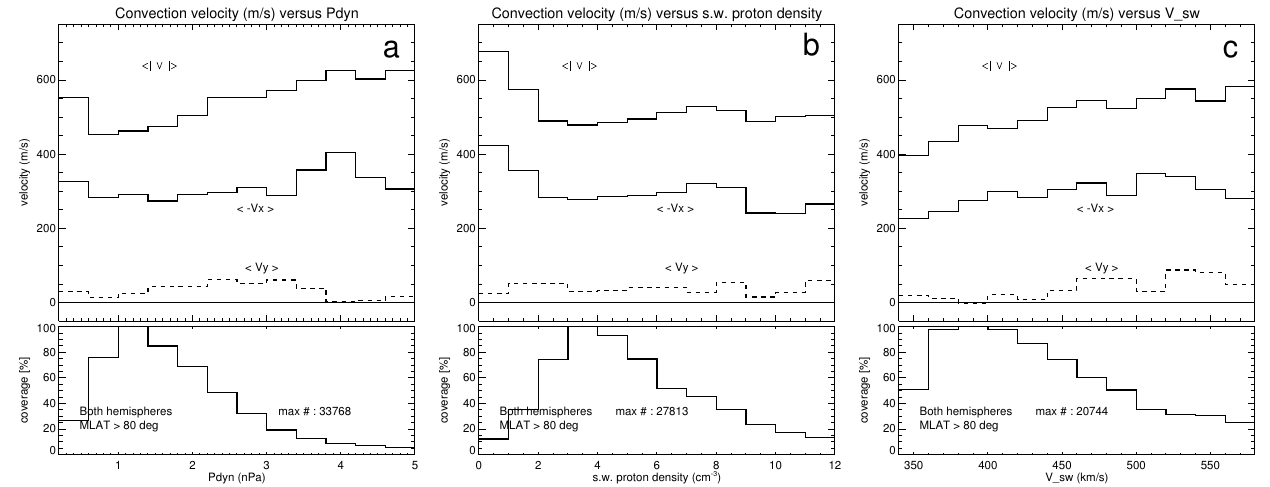
Fig. 10. (a) :The polar cap convection velocity shown as function of the solar wind dynamic pressure P dyn ; (b, c) : the corresponding dependencies of the solar wind proton density n p and velocity | V s.w. | . Data points from both hemispheres have been combined for the analysis. The bottom panels indicate the spatial coverage characteristics for each bin within the high-latitude area ( | φ m | > 80 ◦ ). the dayside reconnection X-line according to the method